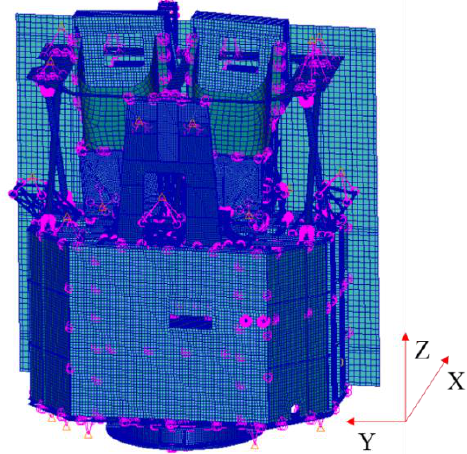
Figure 5. Satellite finite element model (FEM).